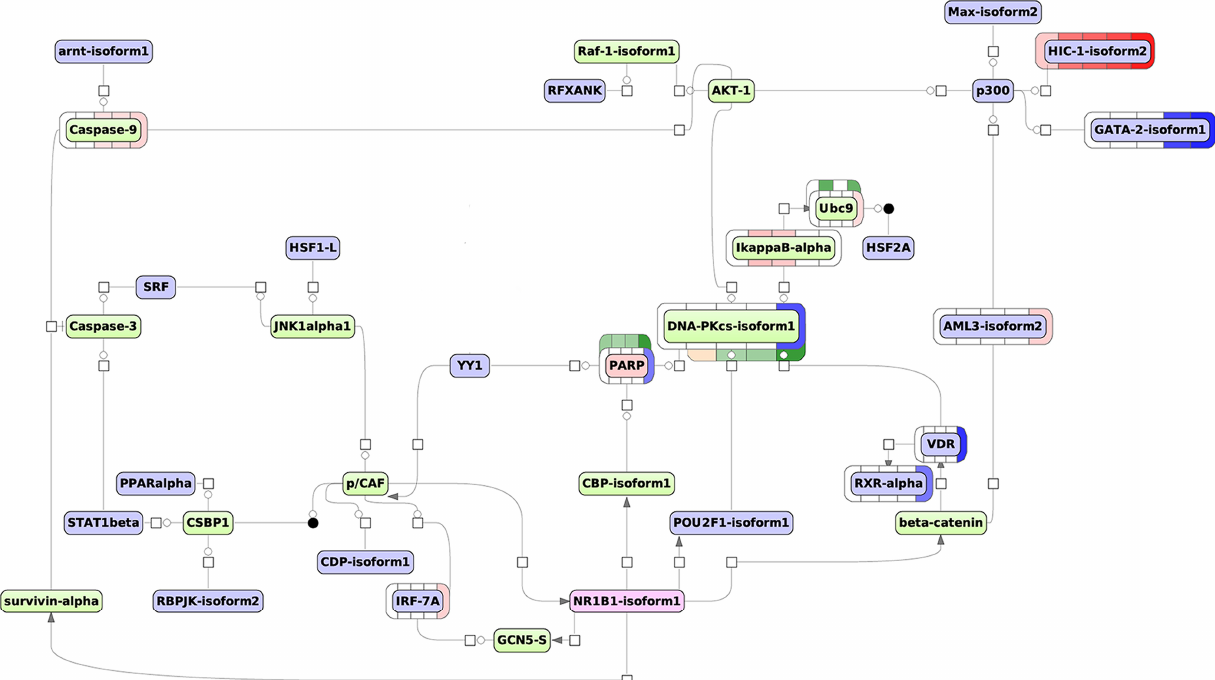
Figure 5. Proteome-based model network of regulation of ATRA-induced HL-60 cell line differentiation (time points 3 h, 24 h, 48 h, and 96 h). Legend: master regulatory molecules are represented by pink ellipses; connecting molecules considered by the graph-analyzing algorithm to find the path from the TF input list to the master molecule are represented by green ellipses; the molecules from the TF input list are represented by lilac ellipses. The colored bars around molecules show changes in the expression. Transcript expression is shown in blue (decreased expression) and pink (increased expression) color array, color intensity correlates with fold-change (FC) of relative mRNA expression, bar is colored if FC ≥ 2, from left to right each bar represent experimental time point (the time points at 3 h, 24 h, and 96 h and additional time points at 0.5 h and 1 h). Protein expression is shown in yellow (decreased expression) and green (increased expression) color array, color intensity correlates with fold-change (FC) of relative protein expression, bar is colored if FC ≥ 1.5, from left to right each bar represent experimental time point (3 h, 24 h, 48 h, and 96h).